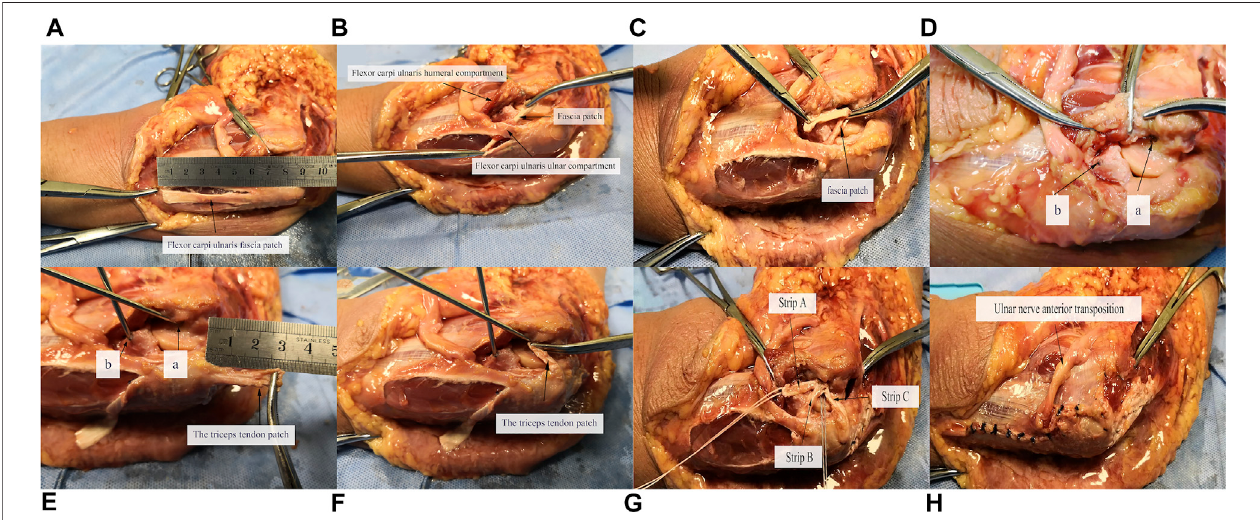
FIGURE1| Illustration oftechnical procedures. (A) Preparation offasciapatch; (B,C) courseoffasciapatch; (D) optionofreconstruction location, a:originpoint of AMCL, b: center of ulnar attachments of AMCL on ulnar ridge; (E) creation of bone tunnels and preparation of triceps tendon patch; (F) course of triceps tendon patch; (G) fi xation of fascia and tendon patches; (H) suture of remaining fascia patch and common fl exor tendon, anterior transposition of ulnar nerve.